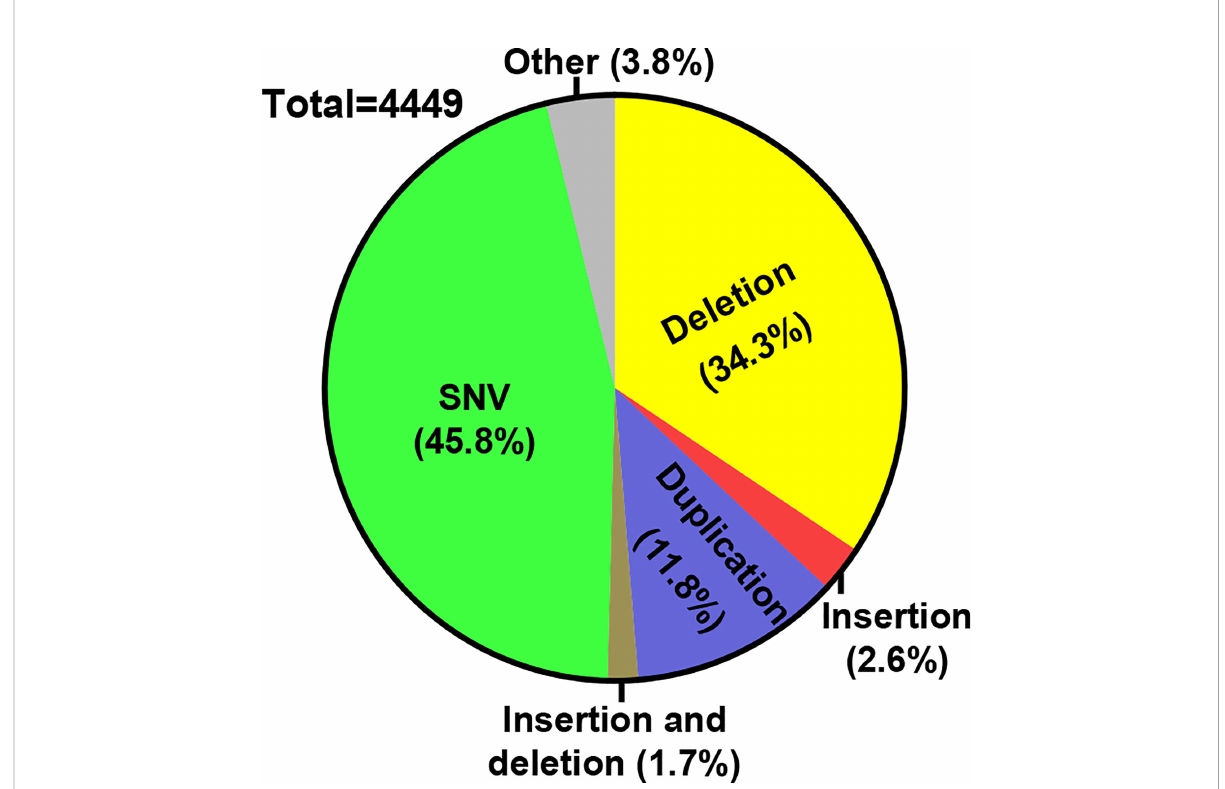
FIGURE 2 Distribution of IEI-associated variants. A survey of ClinVar database was conducted (June, 2022) for the distribution of the pathogenic variants associated with a keyword of “ immunode fi ciency ” . The numbers of different variant types belonging to each of the indicated categories were fi ltered. Subsequently, the percentages for each category of variants within all different variants are marked on the pie